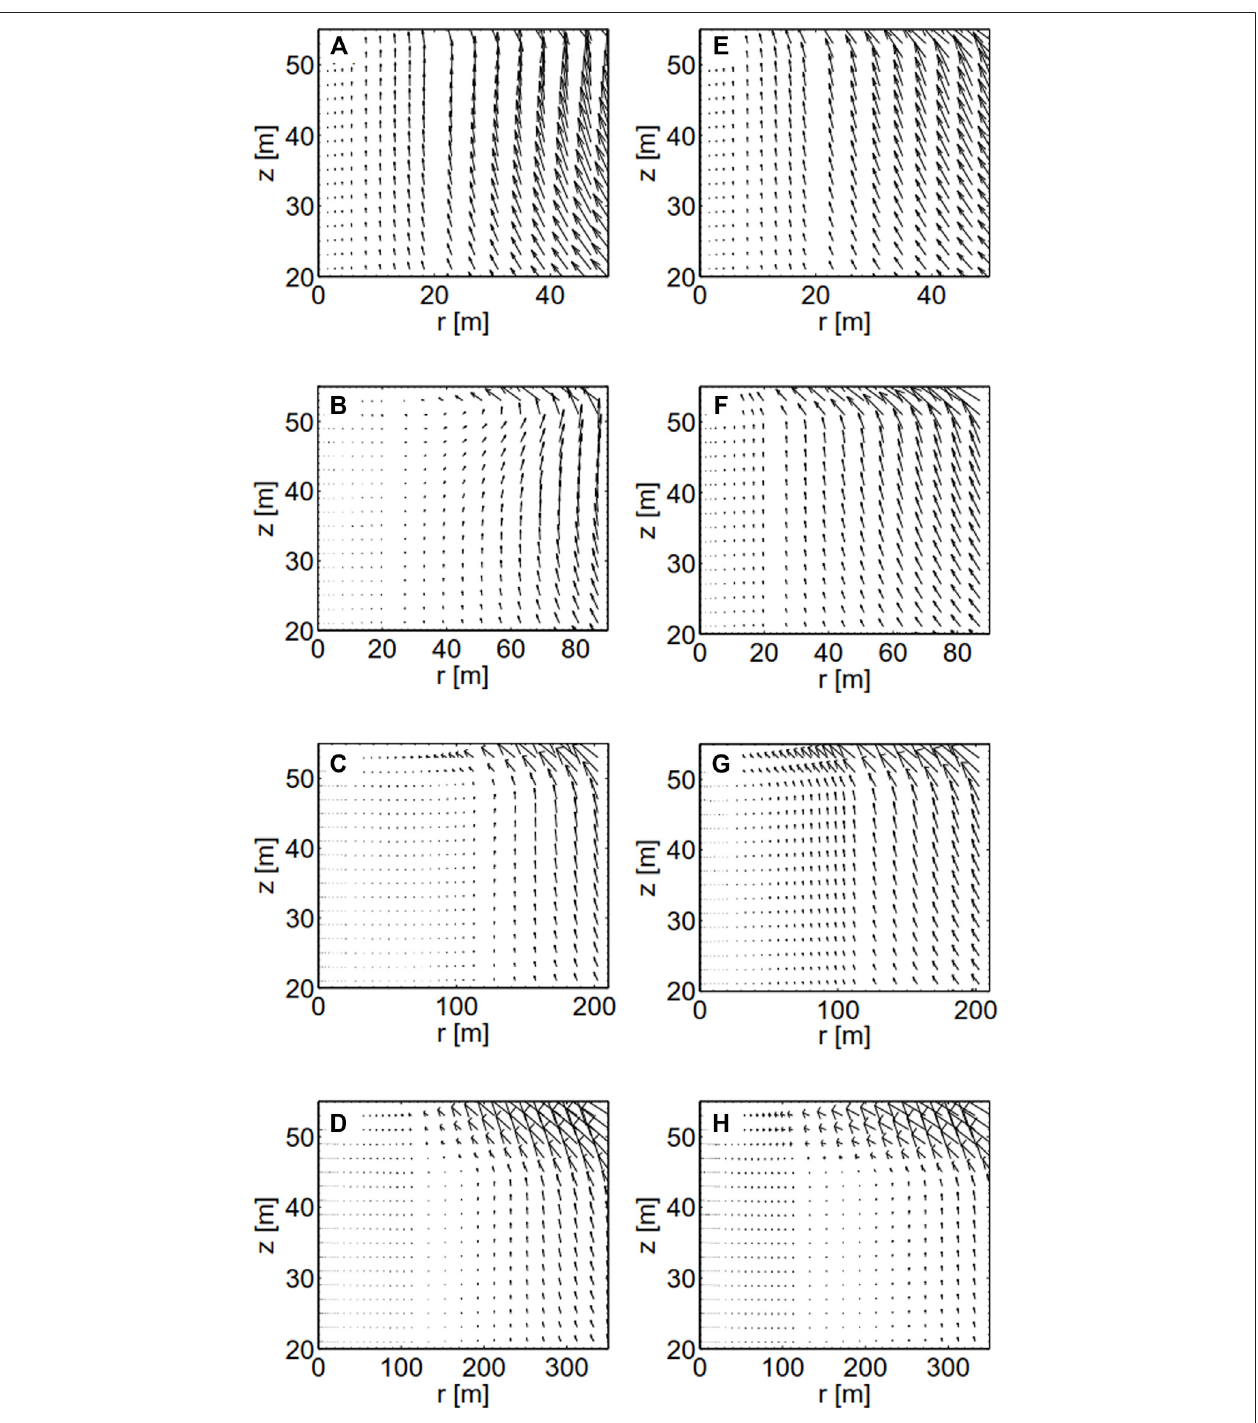
FIGURE 3 | The development of the fl ow regime after 1, 2, 5, and 20 years in the bottom-left saltwater zone in the homogeneous case (A – D) and layered case (E – H) .